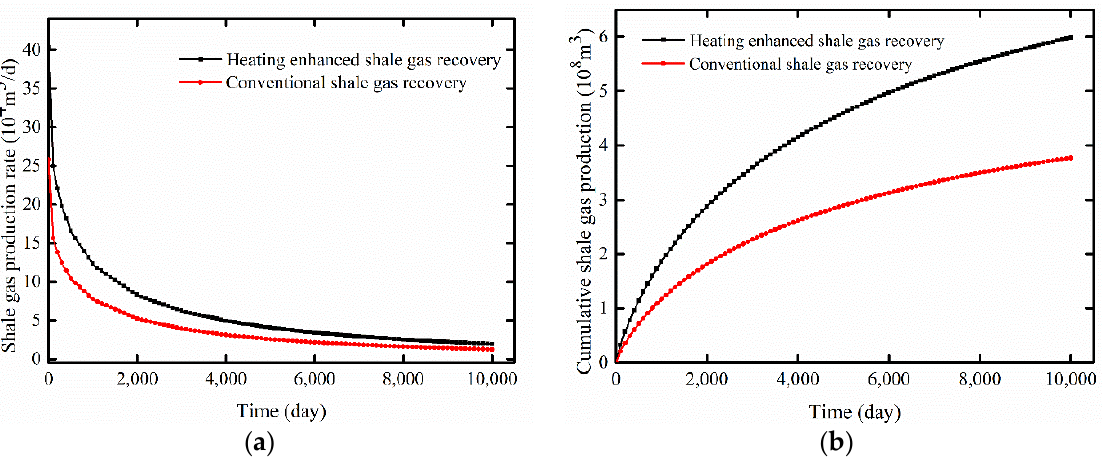
Figure 12. Comparative analysis of gas production between heat injection and conventional exploi ‐ tation of shale gas. ( a ) The shale ‐ gas ‐ production rate and ( b ) cumulative shale ‐ gas ‐ production